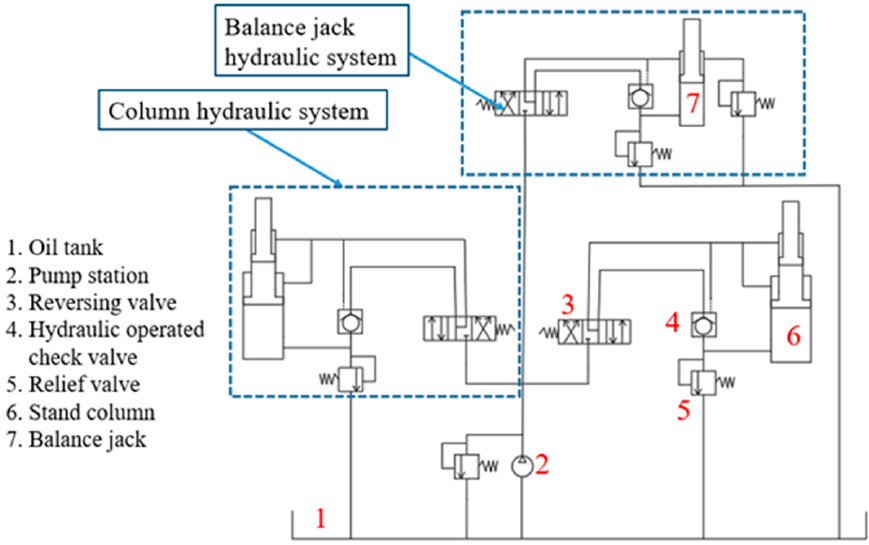
Figure 2. Hydraulic circuit diagram.